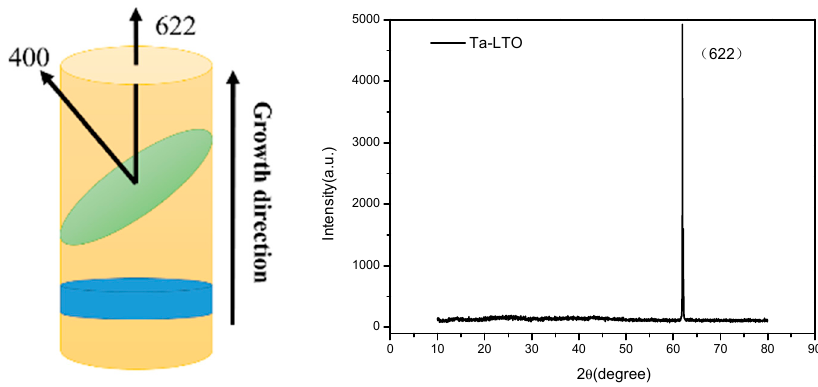
Figure 3. The schematic diagram of the growth direction specimen of Ta-LTO single crystal ( Left ) and the XRD of the Ta-LTO crystal wafer ( Right ).